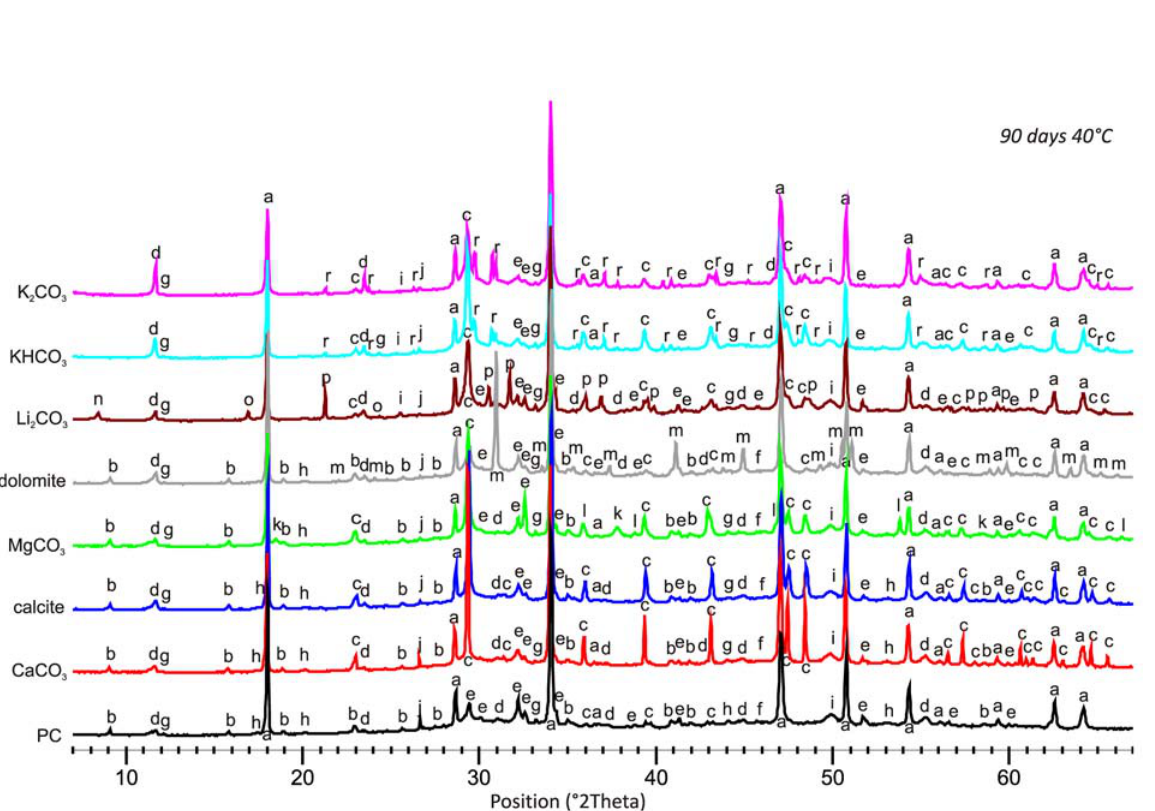
Figure 10 . X-ray diffraction patterns of 90-day hydrated samples at 25 °C/40 °C and phases identified: a-CH; b-E; c-Calcite; d-Mc; e-C g-C AF; h-C AH ; i-4–C–S–H; j-SiO 4 3 6